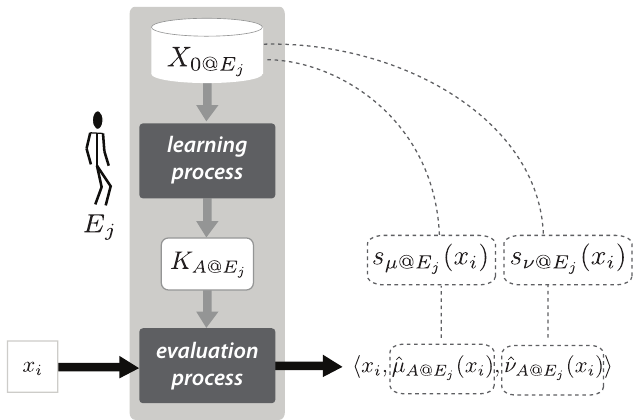
( x ) and s ( x ) , to contextual- i i ν @ E j j used j